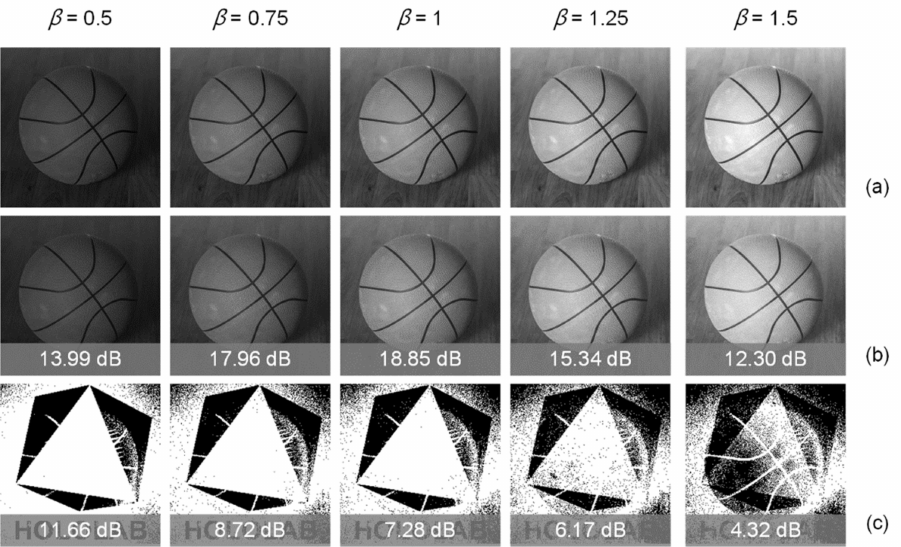
Figure 8. ( a ) The watermarked images with different values of β . ( b ) The reconstructions of decrypted CGHs. ( c ) The extracted watermarks from the